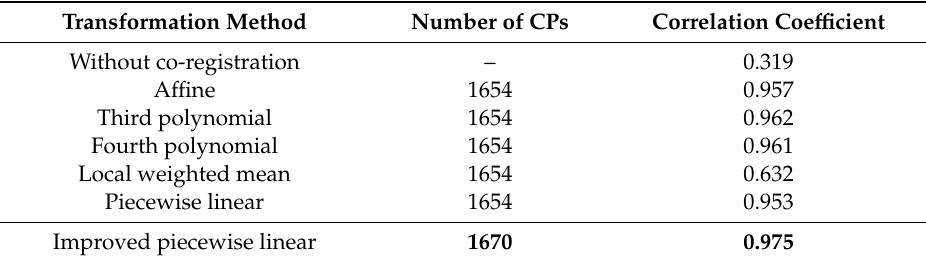
Table 2. Comparative accuracy of warping transformations (simulated dataset).